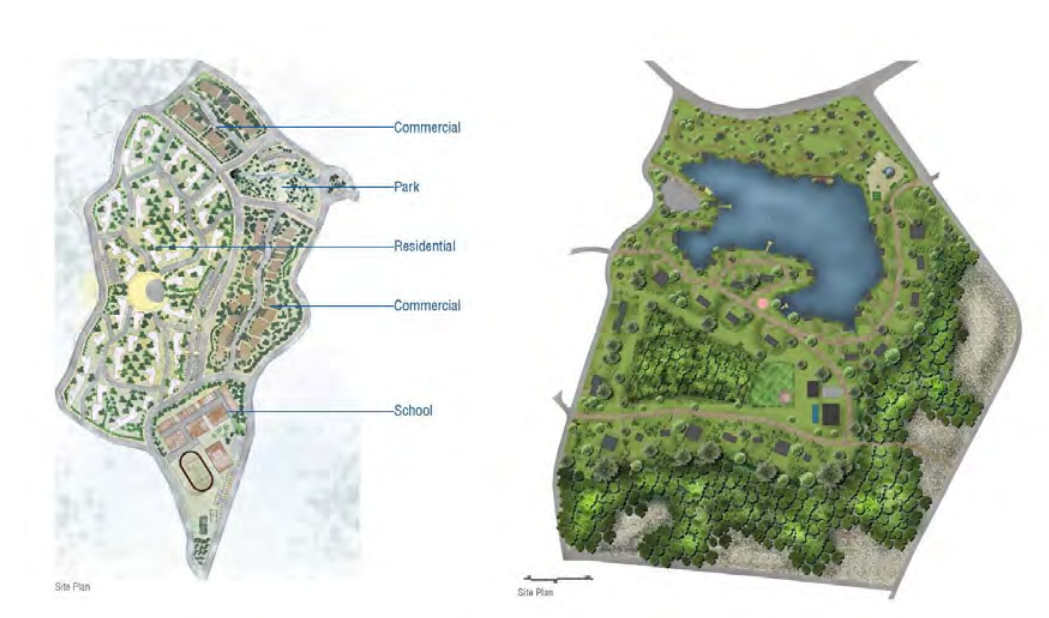
Figure 4. Student’s